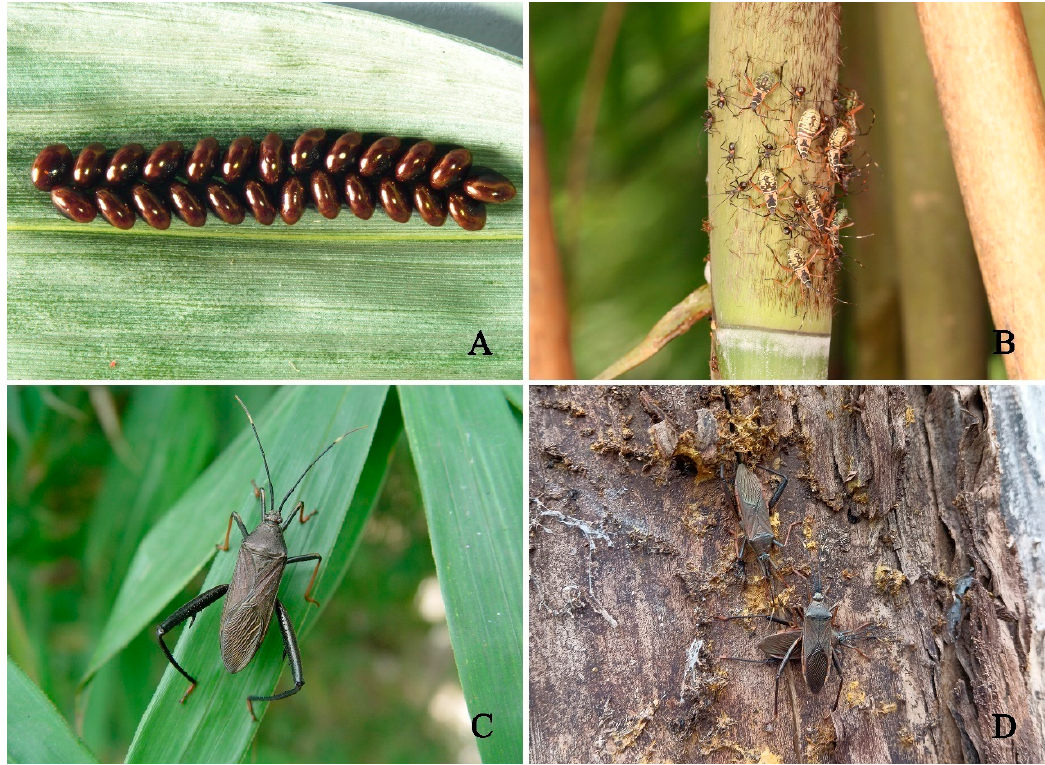
Figure 1. Notobitus melegaris (Fabricius). ( A ). Egg mass; ( B ). Nymphal stages; ( C ). Adult; ( D ). Overwinter ecological habitus of adults.